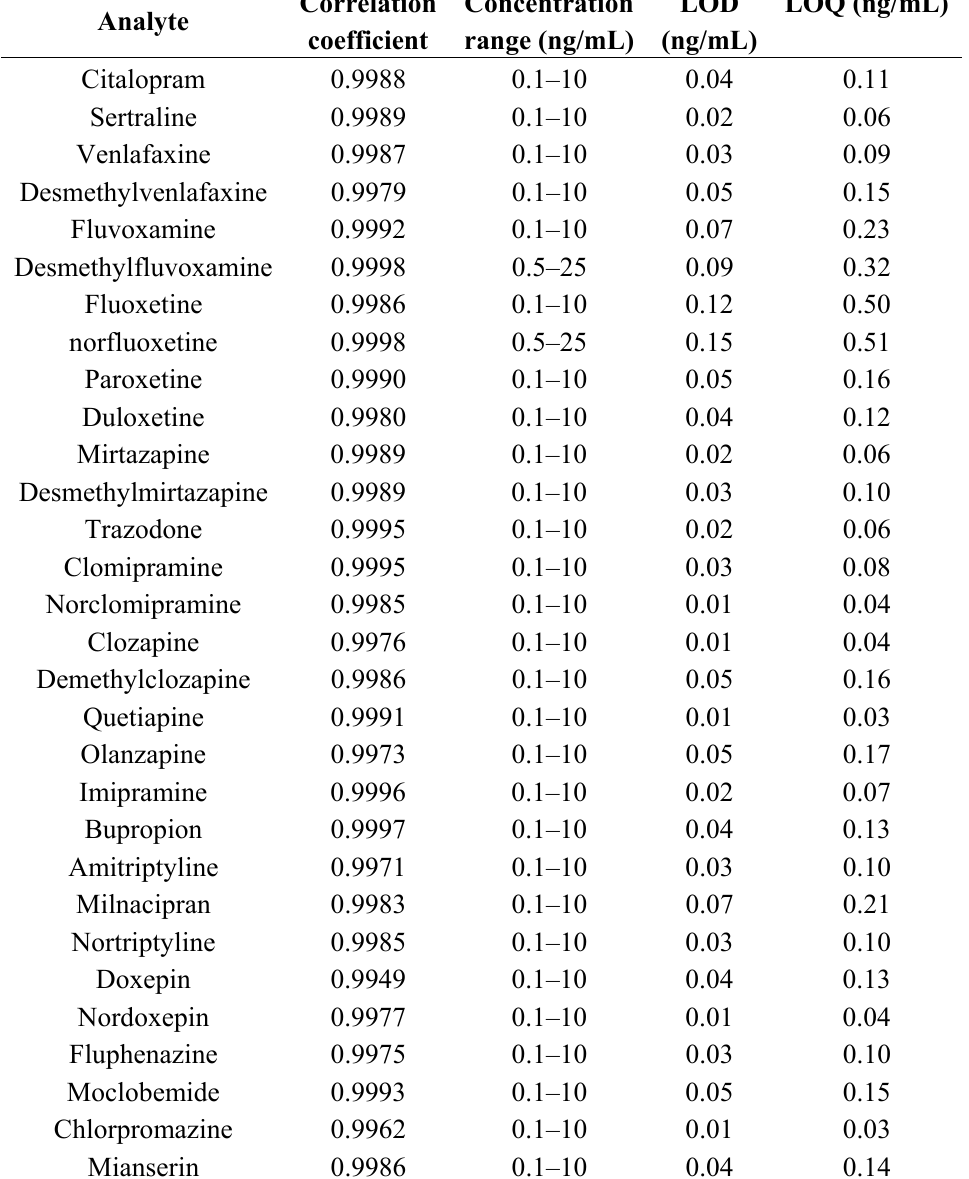
Table 2. Correlation coefficient, linearity range, LOD and LOQ of the